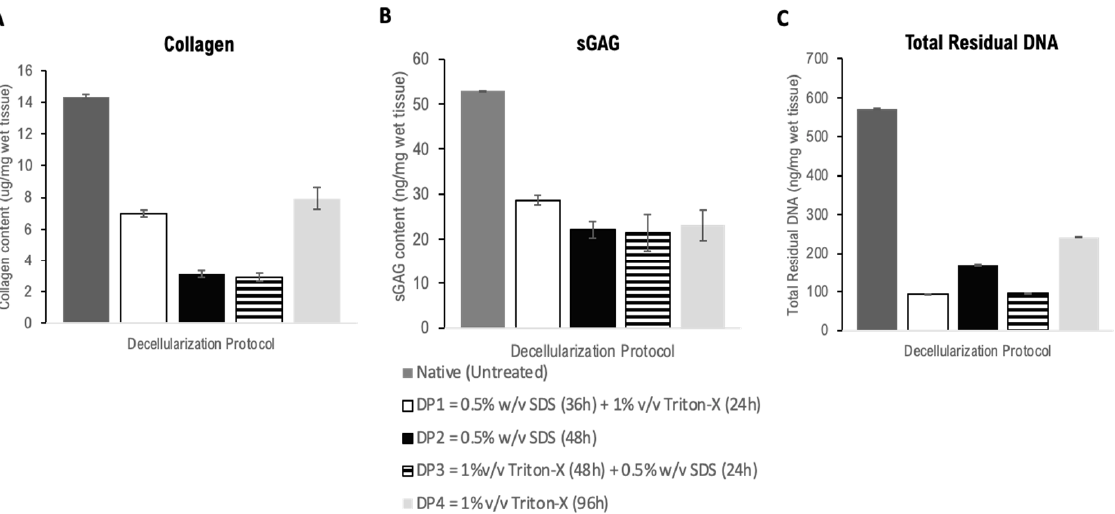
Figure 2. Characterization of the murine renal ECM: ( A ) Quantification of soluble collagen retained post ‐ decellularization with 4 decellularization protocols (DP1–4) using the SIRCOL Soluble Colla ‐